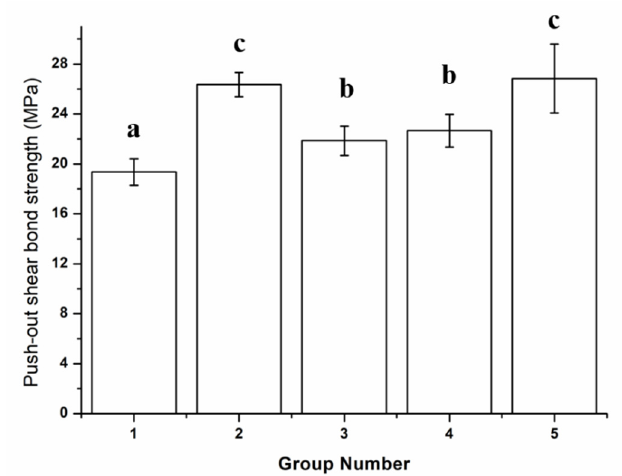
Figure 8. Push-out shear bond strength between group with no surface treatment (1) NTAPP treatment for 1 min; (2) treated with 4% hydrofluoric acid gel for 60 s and then rinsed with running water for 10 s; (3) treated with silane using micro-brush for 60 s; (4) and treated with 4% hydrofluoric acid followed by silane as described earlier; (5) different lowercase letters above the bar indicate a significant difference at p < 0.05 for each group.